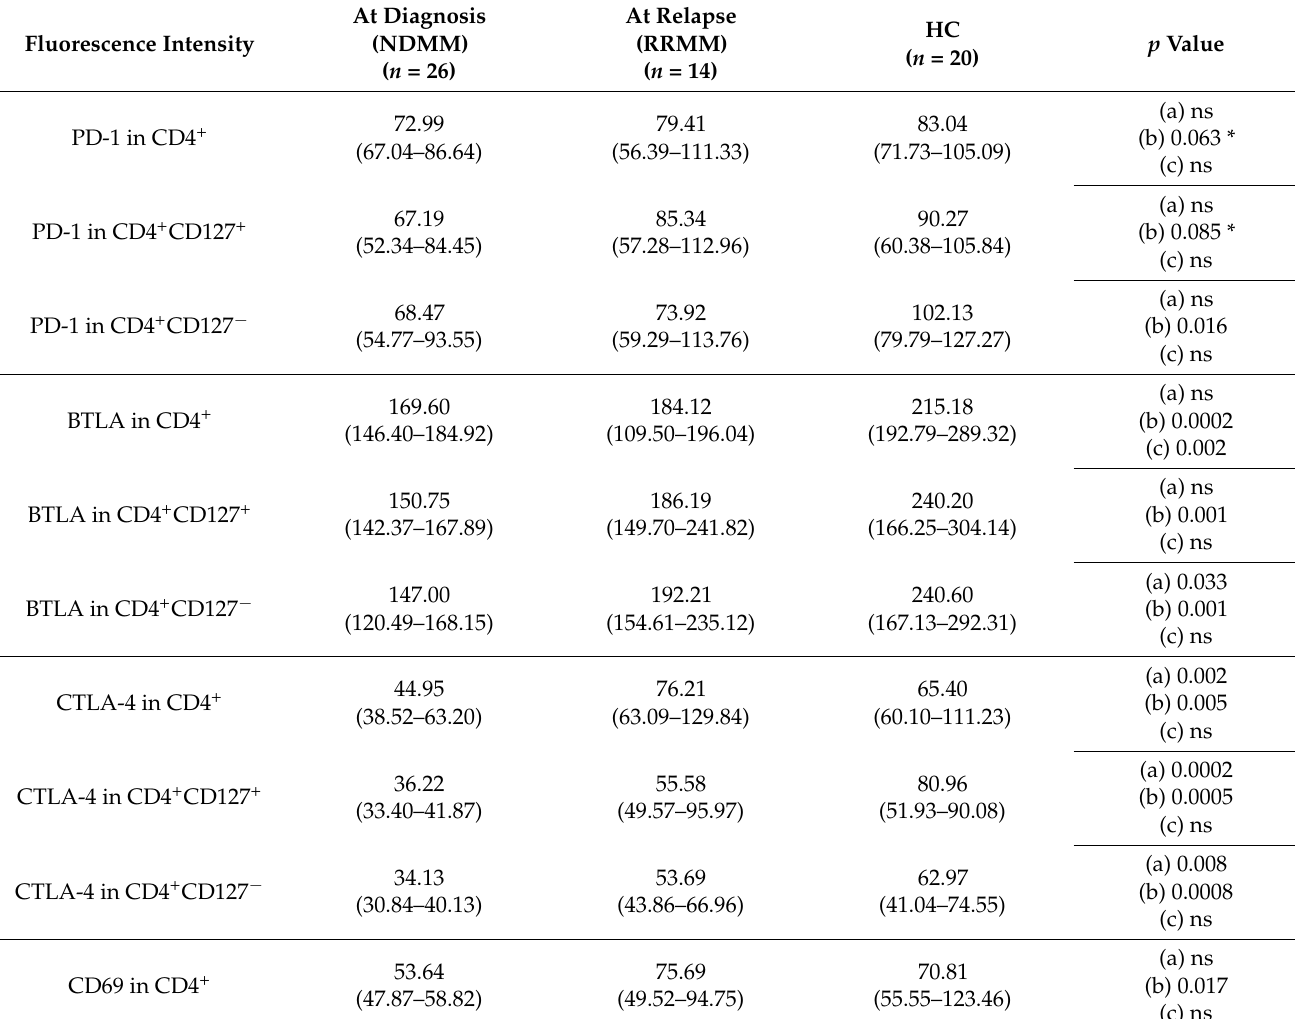
Table 2. Immune checkpoint and CD69 expression (MFI, mean fluorescence intensity) in PB CD4T cells in different MM phases and healthy controls